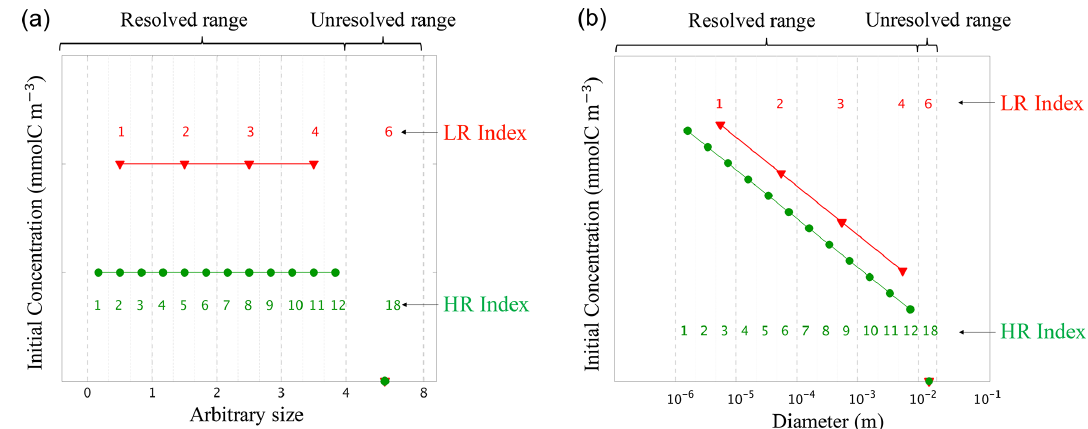
Figure 4. Initial conditions for (a) the linear size discretization (E1) and (b) the nonlinear size discretization (E2), for the two resolutions. The N = 6, while the high resolution (HR), in green, has N = 12 low resolution (LR), in red, has N = 4 size bins plus one unresolved size bin 3 2 N = 18. This is an illustrative example as the HR simulations performed in this paper with N = 400. size bins plus one unresolved bin 3 2 Size bin bounds are shown by vertical dashed grey lines. All simulations are initialized with the same total carbon concentration C T (see Table. 1). The initial concentration is spread uniformly over the resolved range for E1-LR and E1-HR, and following a power law for E2-LR N size bin. As HR has more size bins than LR, concentrations and E2-HR (see Table. 2). No concentration is initialized in the unresolved 3 2 values are consequently lower as determined by C p = C T in E1. Concentrations are prescribed to the middle size value of a given bin. N Table 2. Numerical experiments and associated model configurations and parameters. Run Discretization N K F N n(D) (cid:49)t m 3 s − 1 Linear